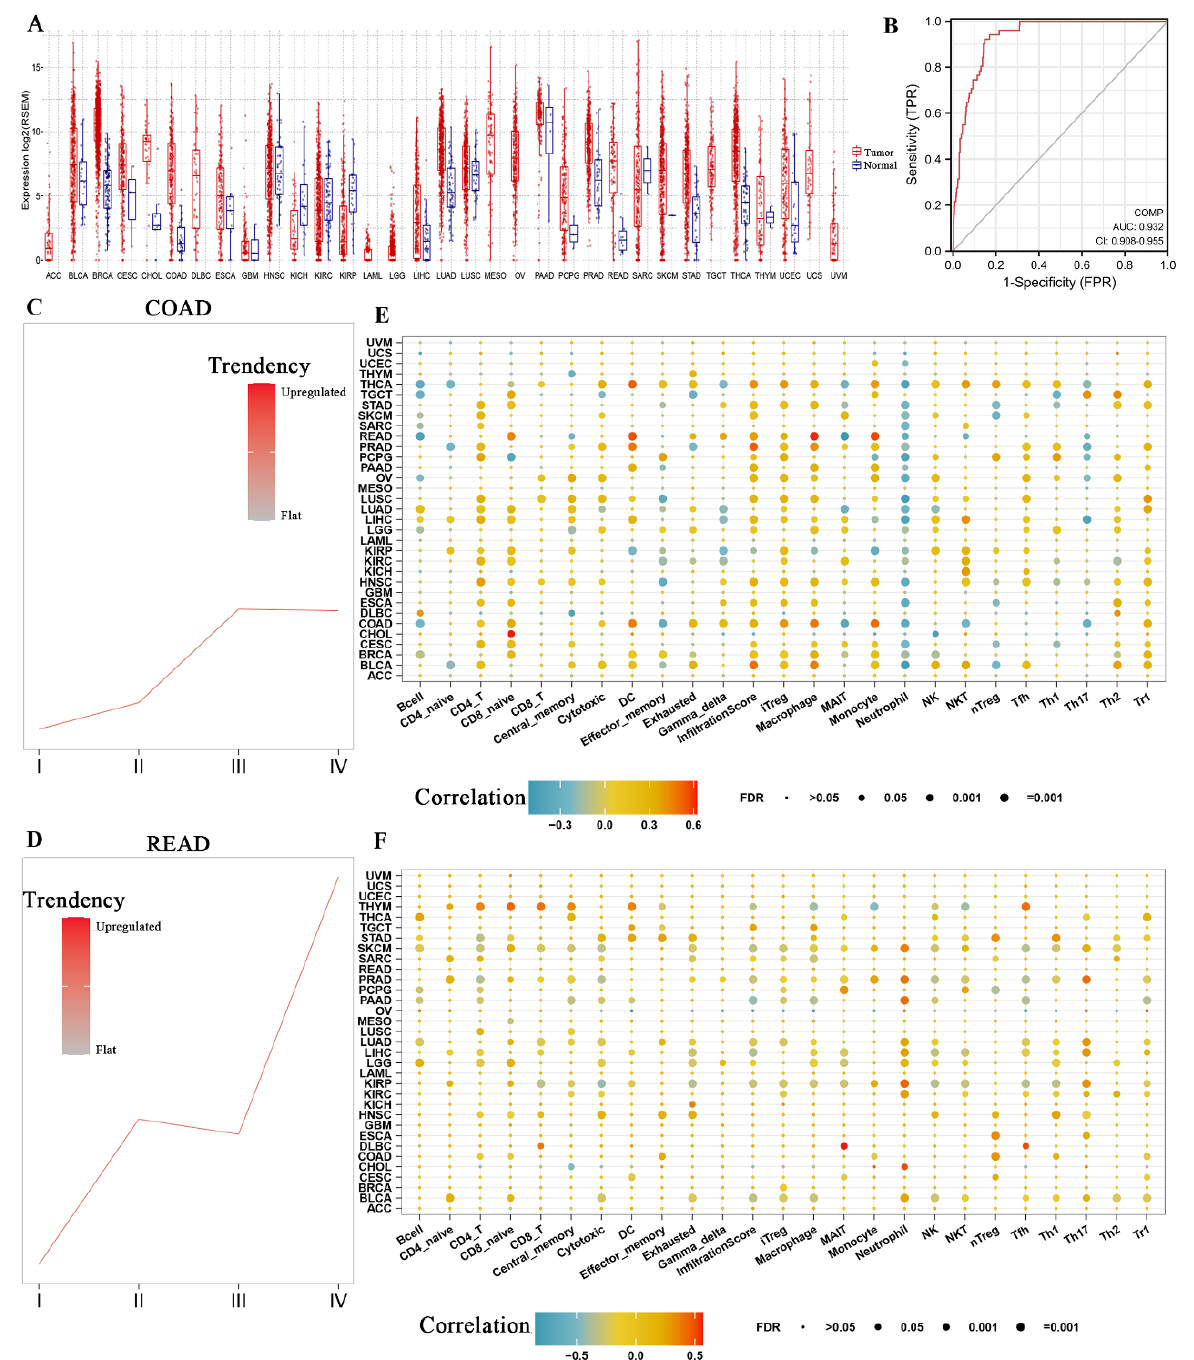
Figure 5. The expression differences of COMP in cancer and the correlation with immune infiltra- tion. ( A ) A pan-cancer analysis for the expression differences of COMP between tumor and normal tissues. ( B ) ROC exhibited an excellent diagnostic role of COMP for CRCs with an AUC equaling 0.932. ( C ) COMP was upregulated in advanced COAD. ( D ) COMP was upregulated in advanced READ. ( E ) The correlation between COMP and immune infiltration in pan cancers. ( F ) The correla- tion between COMP methylation and immune infiltration in pan